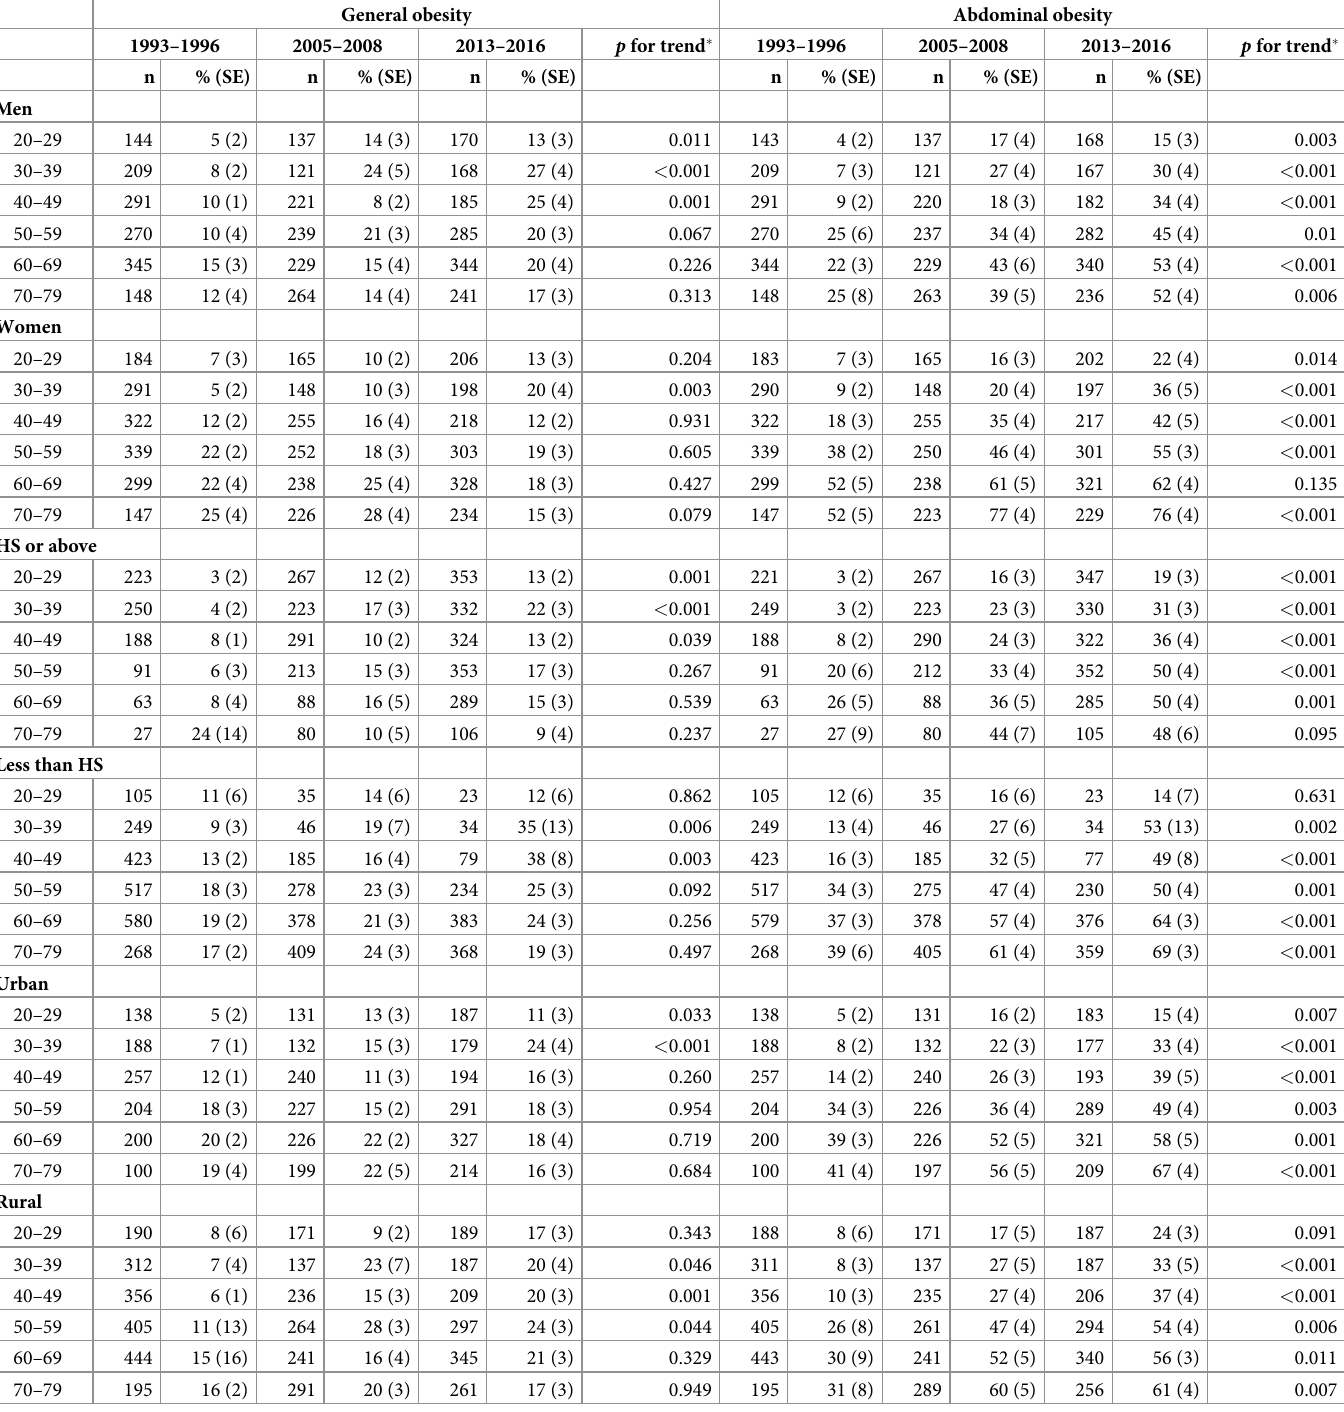
Table 4. Trends in prevalence of general and abdominal obesity among Taiwanese adults: the NAHSIT